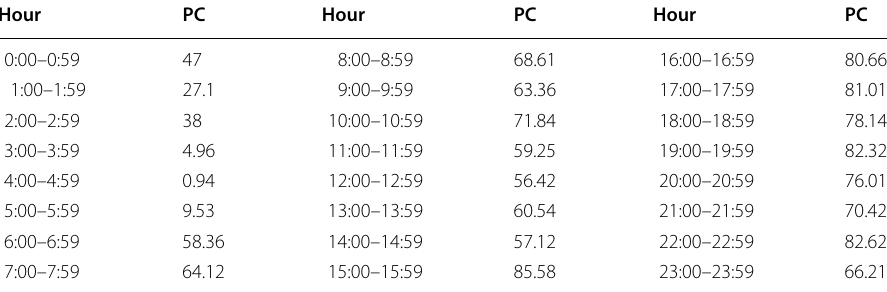
Table 8 Hourly NO PC of A_1 (μg/m 3 ) x Hour PC Hour PC